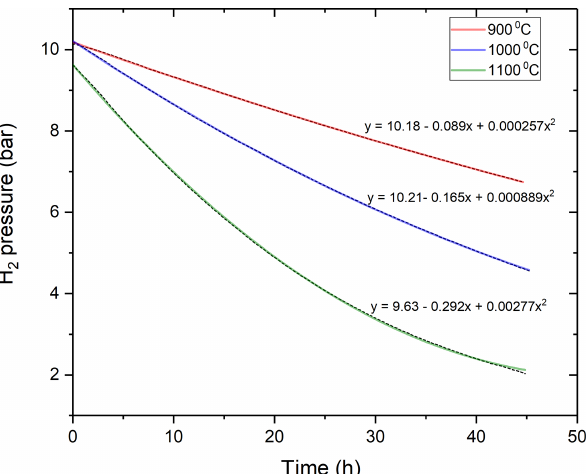
Figure 3. Hydrogen flux out of the MHC vessel as a function of H 2 pressure inside the vessel, and thus f H 2 gradient. It is apparent that the flux of hydrogen through the MHC pressure vessel walls is linearly proportional to the pressure gradient between interior and exterior of the vessel at all investigated